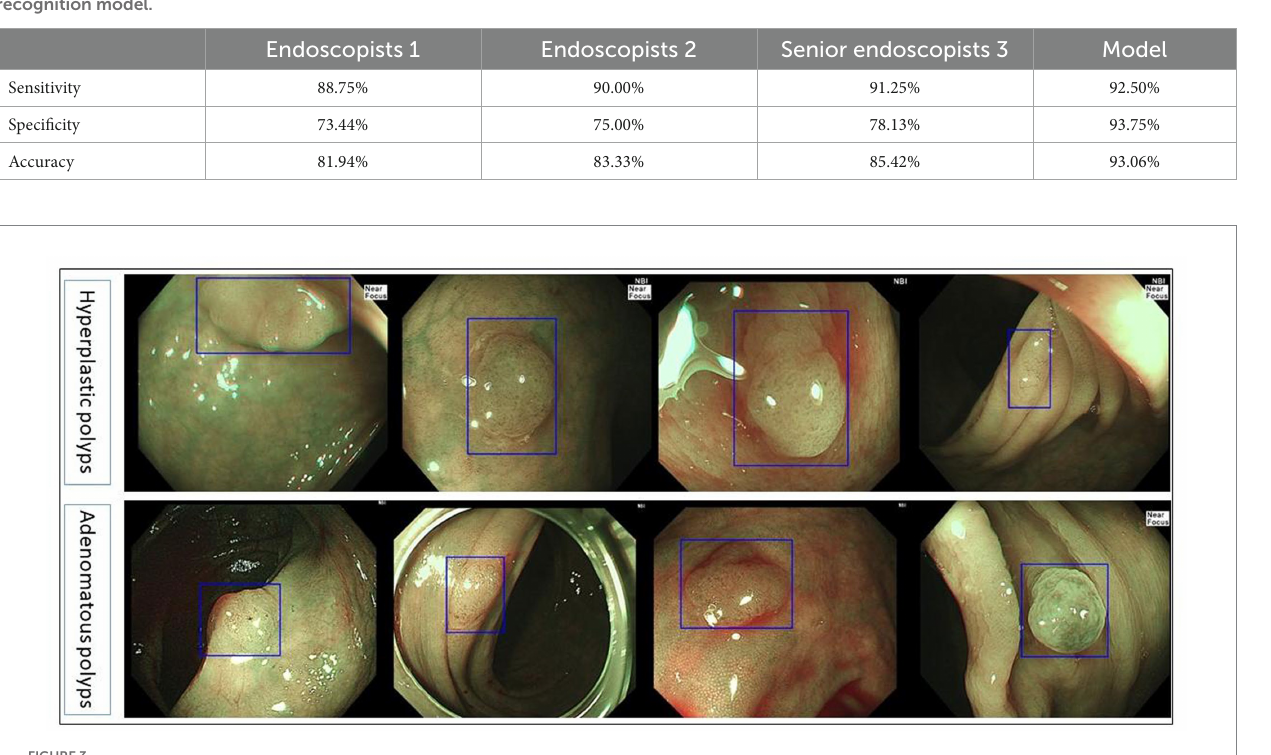
FIGURE 3 Typical images of misdiagnosed colorectal adenoma by the colorectal adenoma recognition